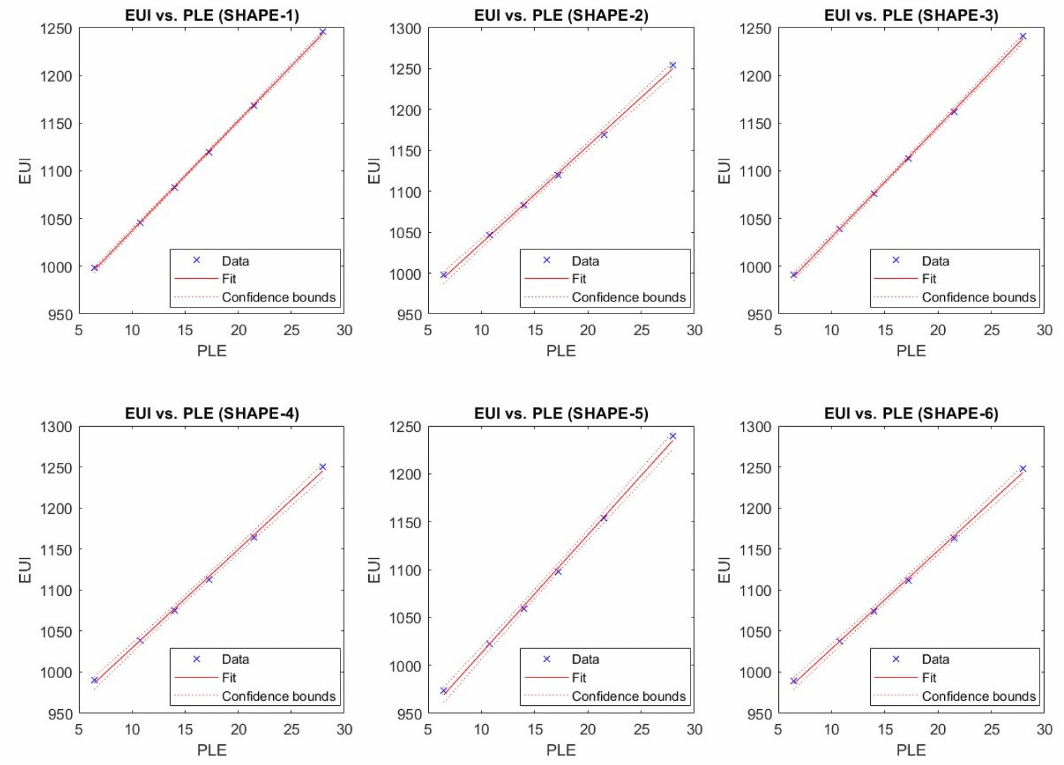
Figure 15. Fitted lines of plug load efficiency.